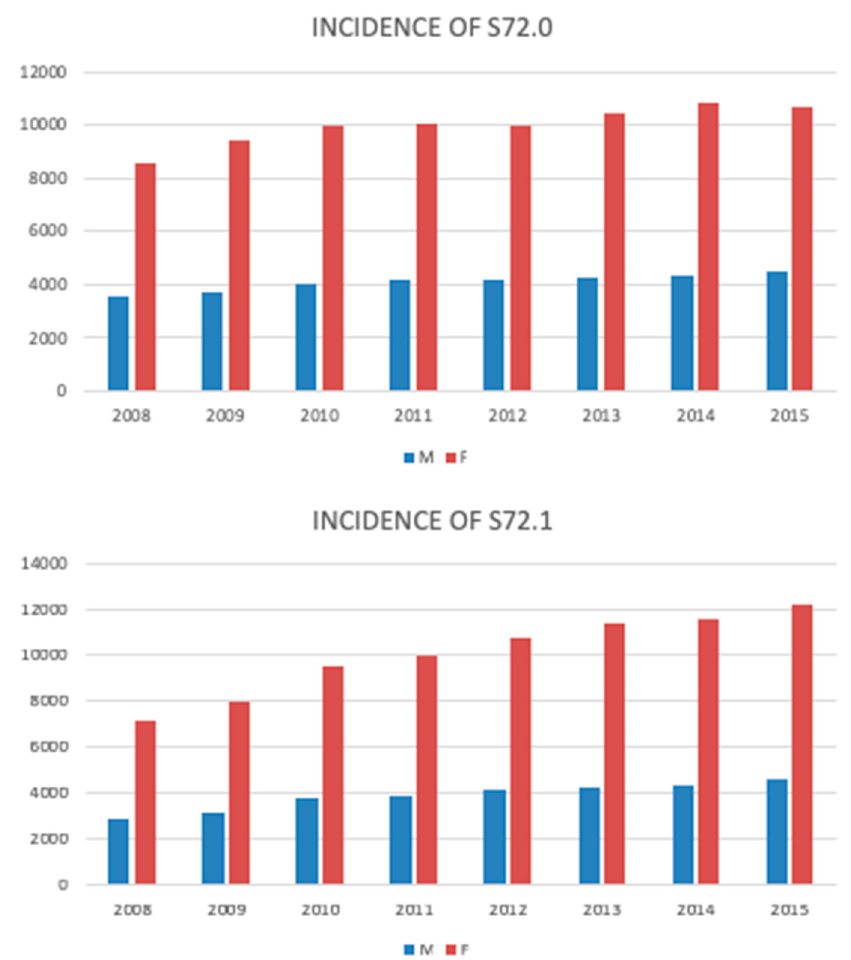
Figure 4. The incidence of the femoral neck (S72.0) and pertrochanteric fracture (S72.1) in men and women during the study period